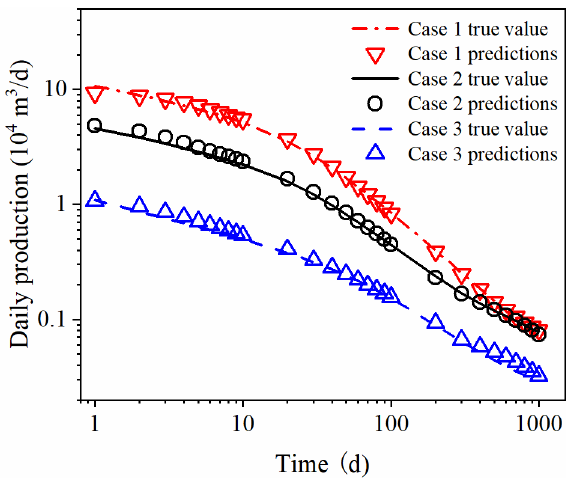
Figure 2. Comparison of the predictions by MLP networks and the true values of the daily production under three constraints.